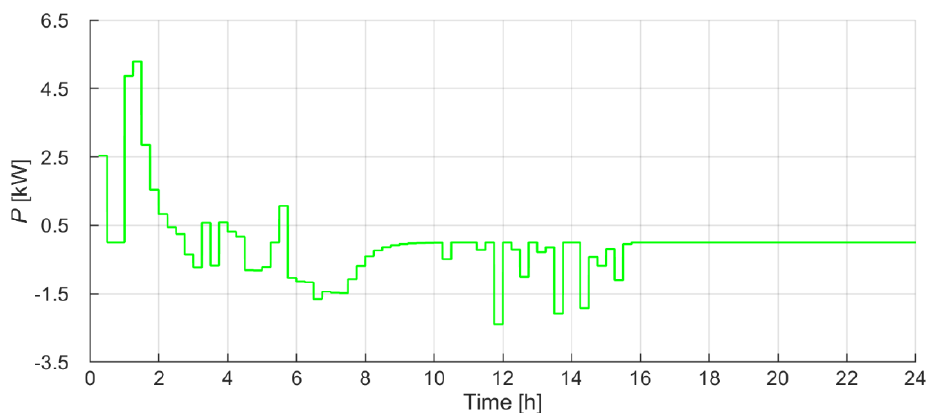
Figure 13. Daily active power variation of the energy storage unit ES_530 (installed in node 530); profile A.